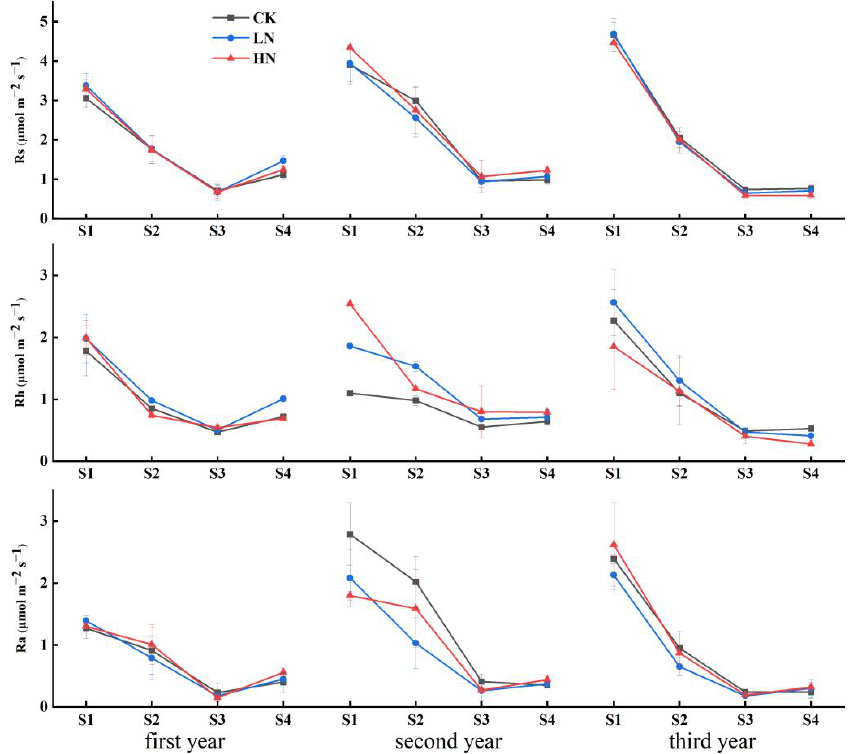
Figure 2. Seasonal dynamics of soil respiration (Rs), autotrophic respiration (Ra), and heterotrophic respiration (Rh) during the study period. Data are presented in terms of mean ± standard deviation values. S1, mid-growing season; S2, late growing season; S3, non-growing season; S4, early growing season. CK, LN, and HN represent control, low, and high nitrogen applications, respectively. Table 2. Results (F-values) of the repeated-measures analysis of variance performed to evaluate the effects of season or year, nitrogen application, and their interaction on soil respiration and its components.